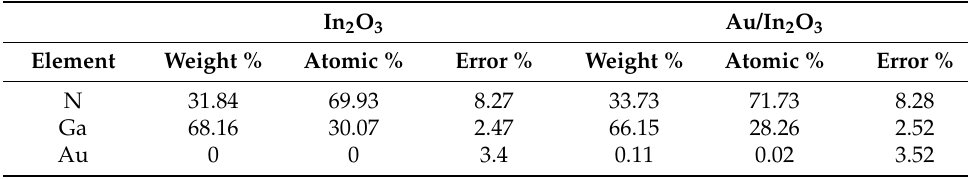
Table 1. EDS weight and atomic ratio analysis for In 2 O 3 and Au/In 2 O 3 sensors.